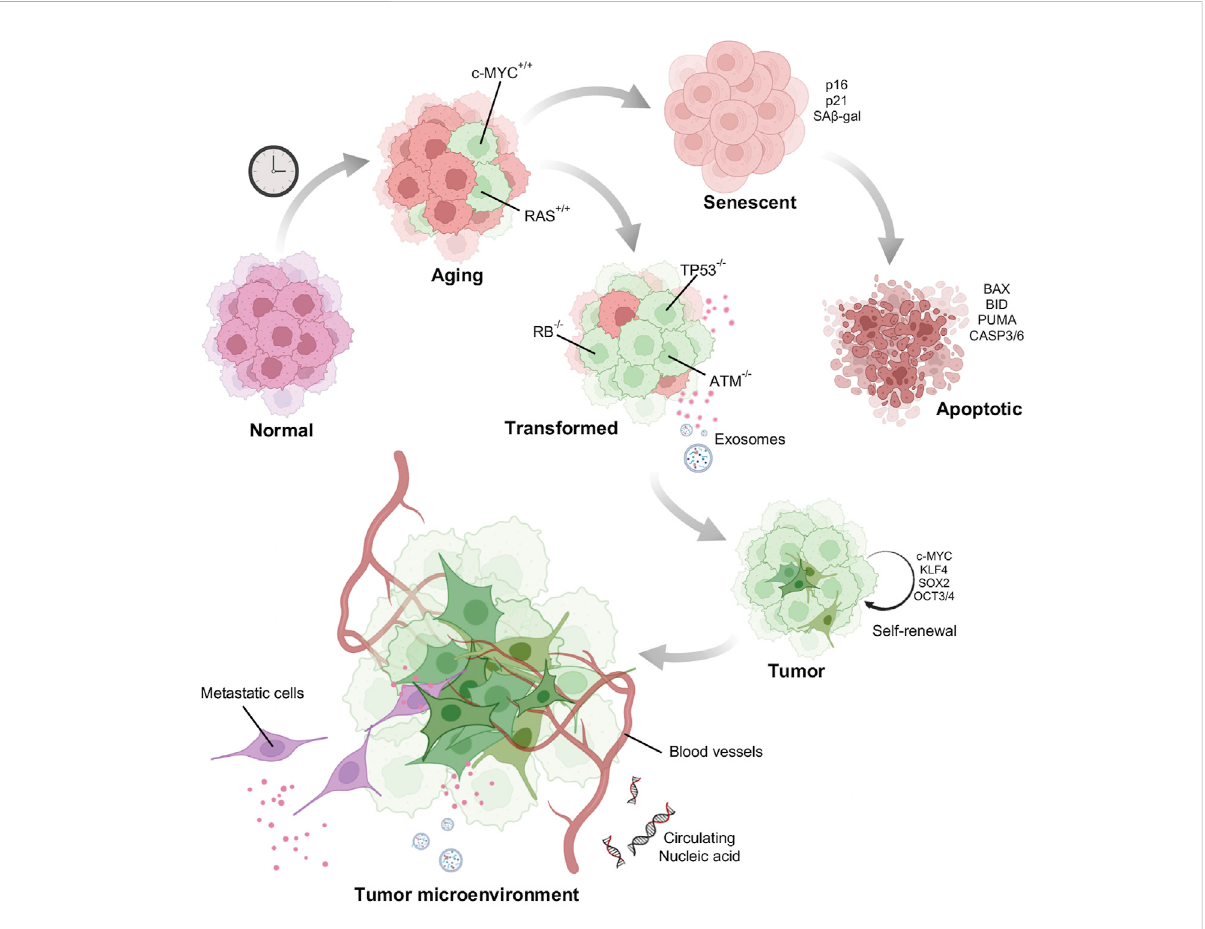
FIGURE 4 Model of how aged cells potentiate tumor formation: Normal young cells accumulate DNA damage and senesce. A few of the damaged old cells acquire mutations such as activation of oncogenes to induce oncogene induced senescence. Senescent cells after acquiring enormous DNA damage might be directed towards apoptotic pathway. Some cells however, escape death by acquiring other mutations and gain self-renewal property behaving as potential stem cells. Tumor cells once formed is also facilitated by the aging stroma for its growth and